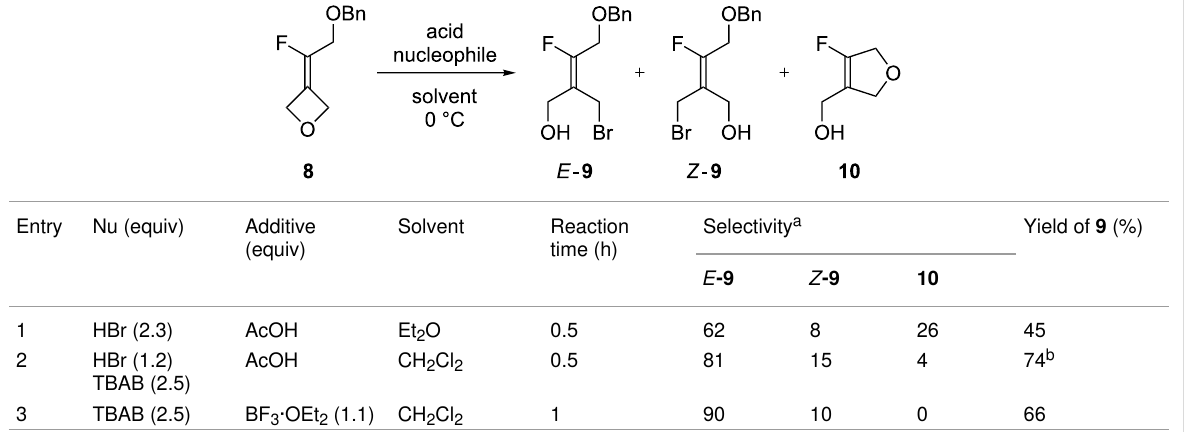
Table 3: Opening of the benzyloxy-substituted fluoroethylideneoxetane derivative 8